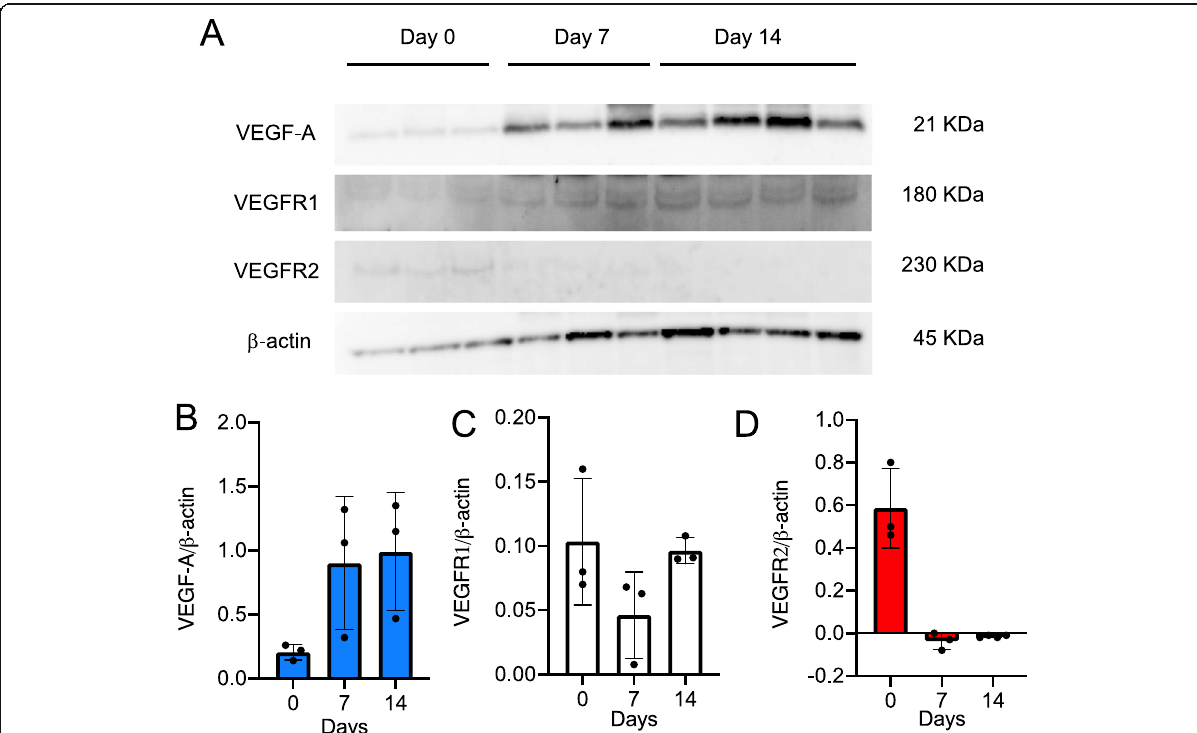
Fig. 1 The protein level of VEGF receptors in the lung after BLM treatment. a The protein level of VEGF-A, VEGFR1, and VEGFR2 were evaluated by western blot analysis. b – d Statistical analysis of VEGF-A ( d ), VEGFR1 ( e ), and VEGFR2 ( f ) was determined and normalized to β -actin. Data are expressed as the mean ± SD (n = 3 mice per group)